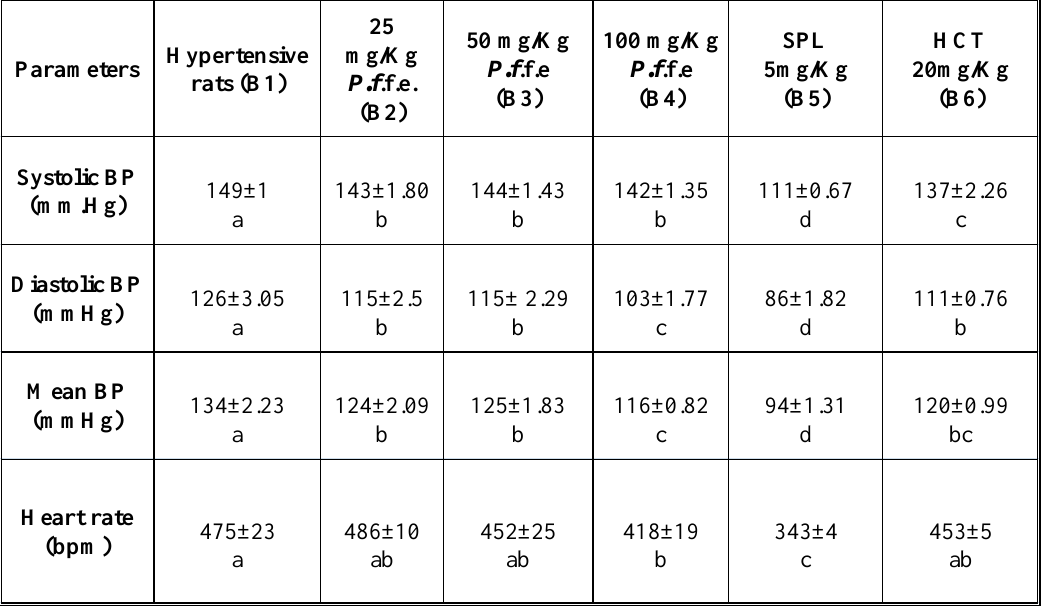
Table 5. Effect of different doses of P. farcta fruit decoction ,Spironolactone (5mg/kg), and Hydrochlorothiazide (20mg/kg) on hypertensive